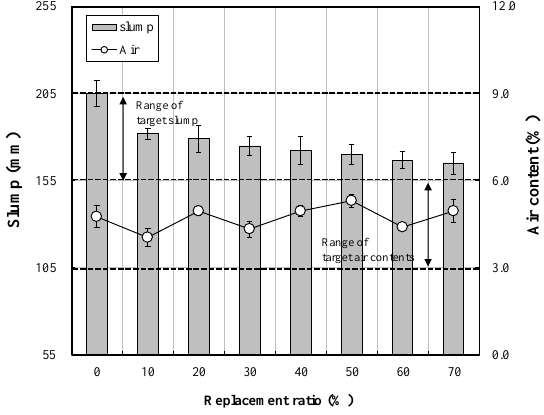
Figure 5. Result of slump and air contents with respect to replacement ratio.